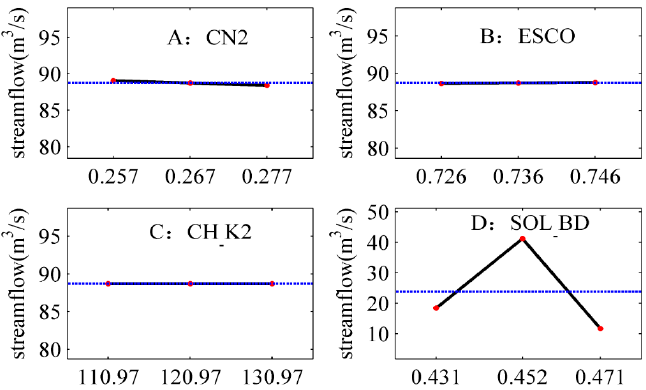
Figure 6. Individual effects of parameters in the non-flood period.